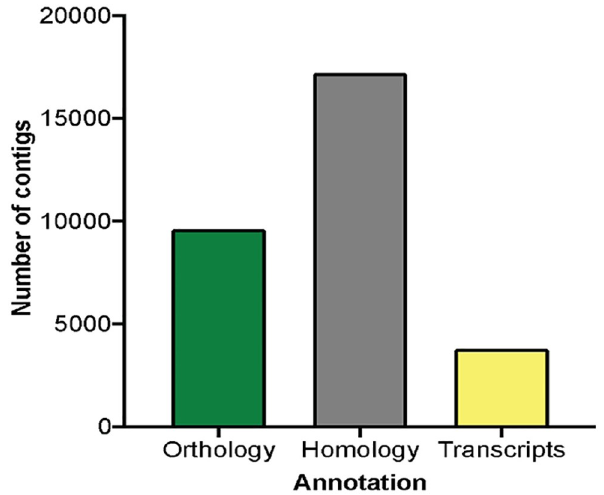
Fig 1. De novo transcriptome annotation homology. A total of 30,576 contigs was annotated by blastx and tblastn. Reciprocal best hits yield 9,600 (31.3%) contigs annotated by orthology; green bar. BLAST best hits yield 17,197 (56.2%) contigs annotated by putative homology; gray bar. The remaining 3,779 (12.4%) contigs were annotated by transcript families; yellow bar.